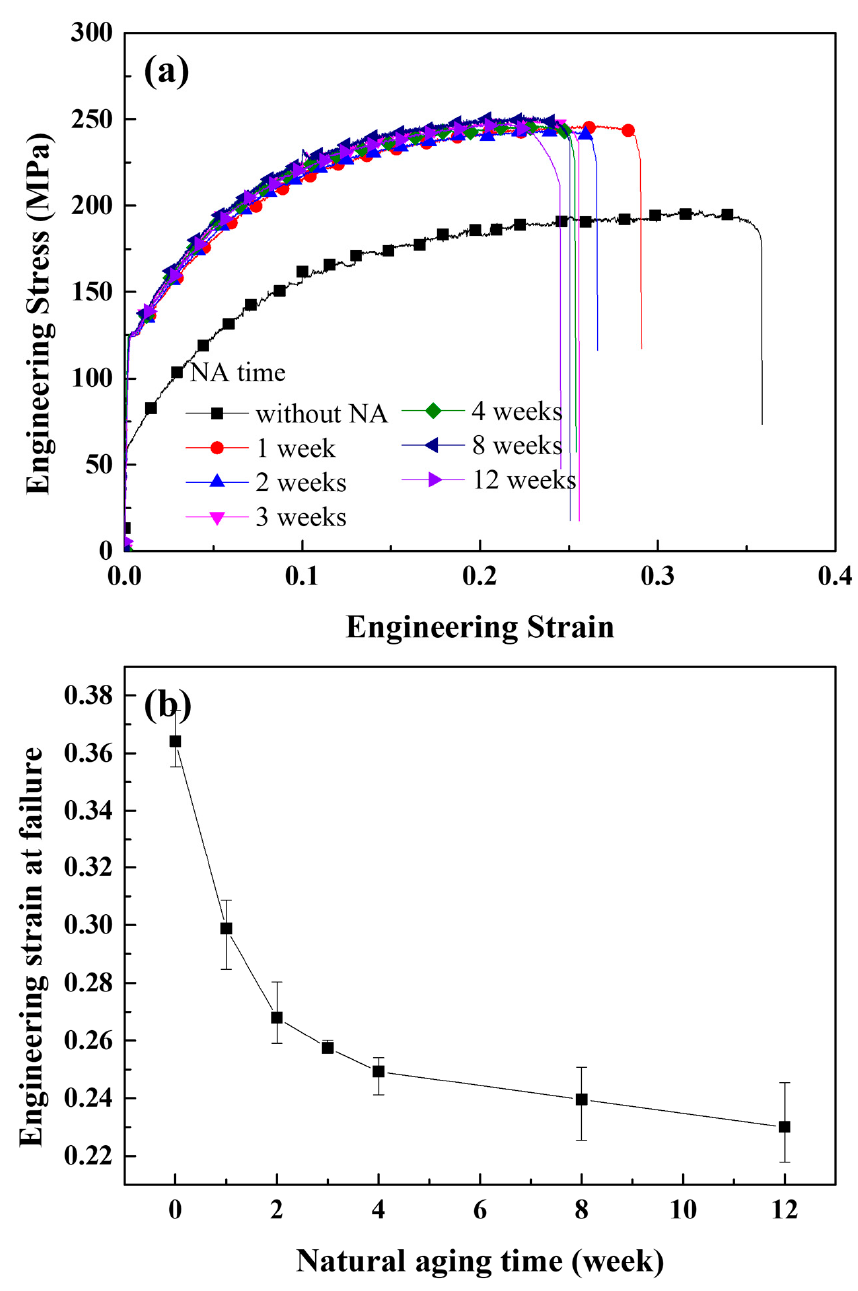
Figure 2. Experimentally obtained mechanical properties of the investigated Al–Si–Mg-based alloy. ( a ) Engineering stress-strain curve with various natural aging times and ( b ) engineering strain at failure as a function of the natural aging time.